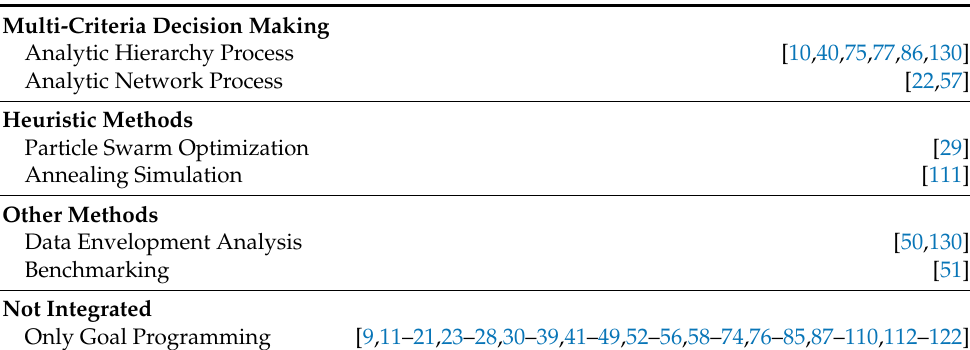
Table 5. The studies integrated with goal